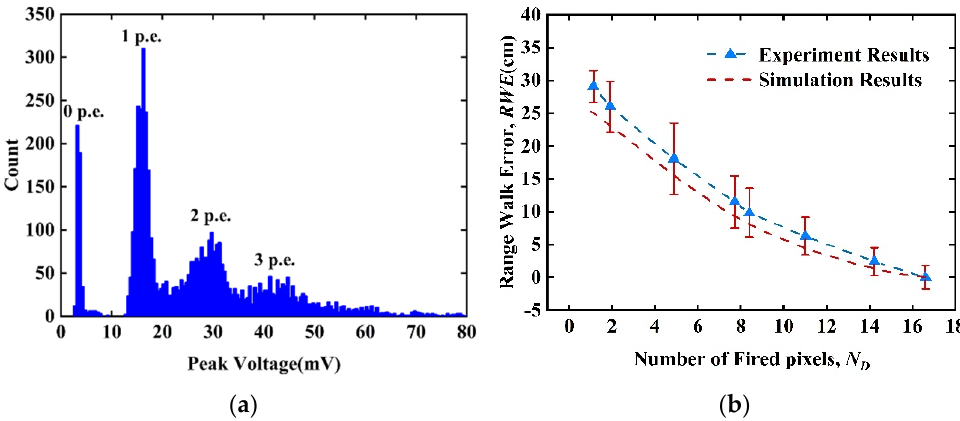
Figure A2. ( a ) Peak voltage of SiPM distribution at N D = 1.91. ( b ) Experiment and simulation results of RWE.